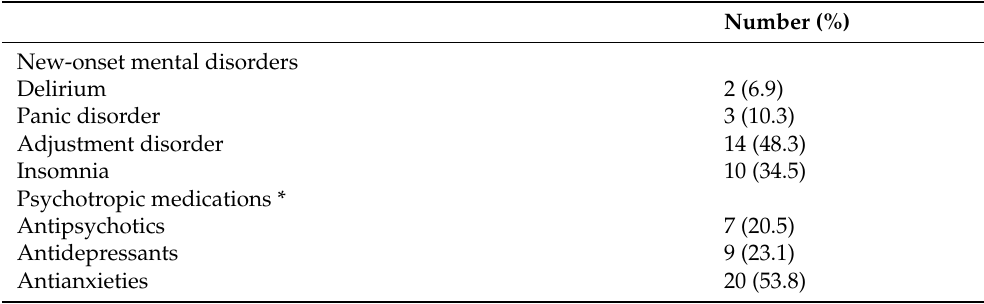
Table 3. New-onset mental disorders and psychotropic medications prescribed during